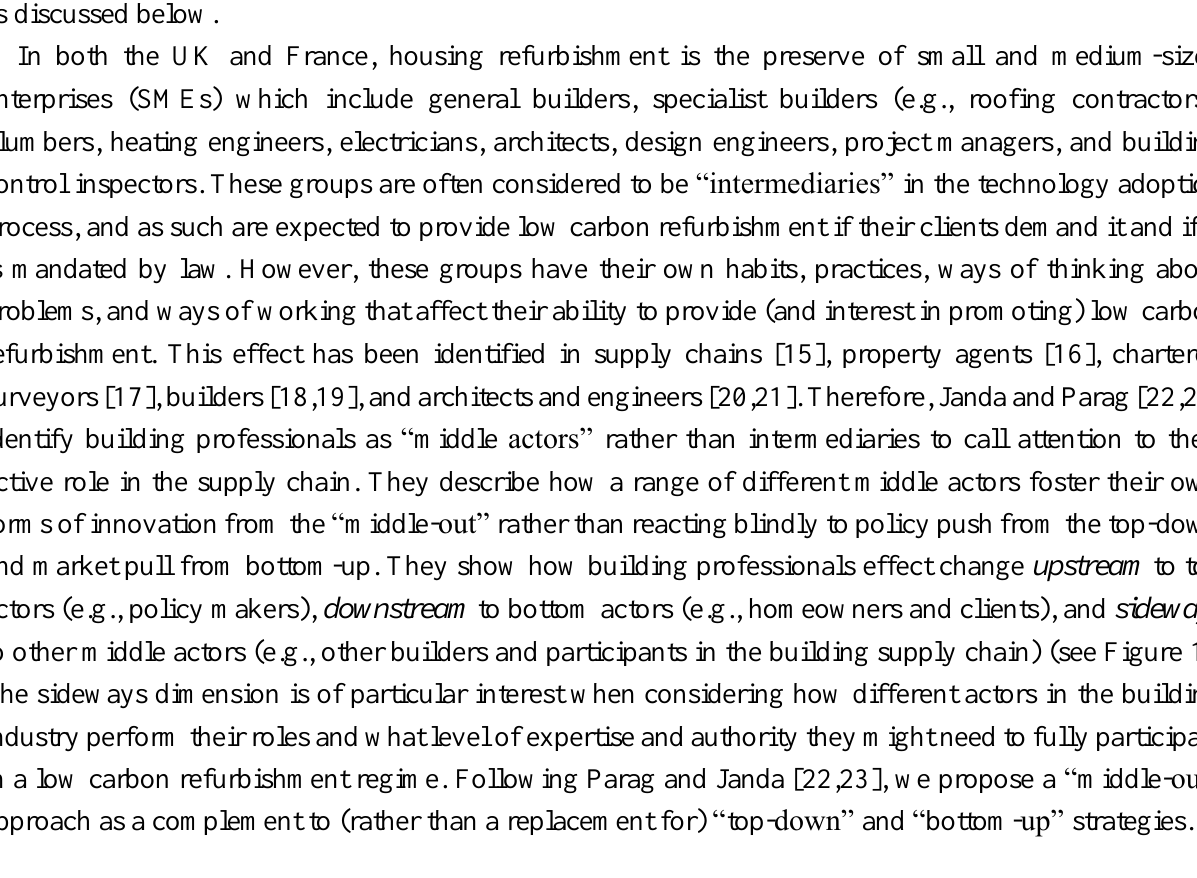
Figure 1. Middle-out approach to change: directions of middle-actor influences